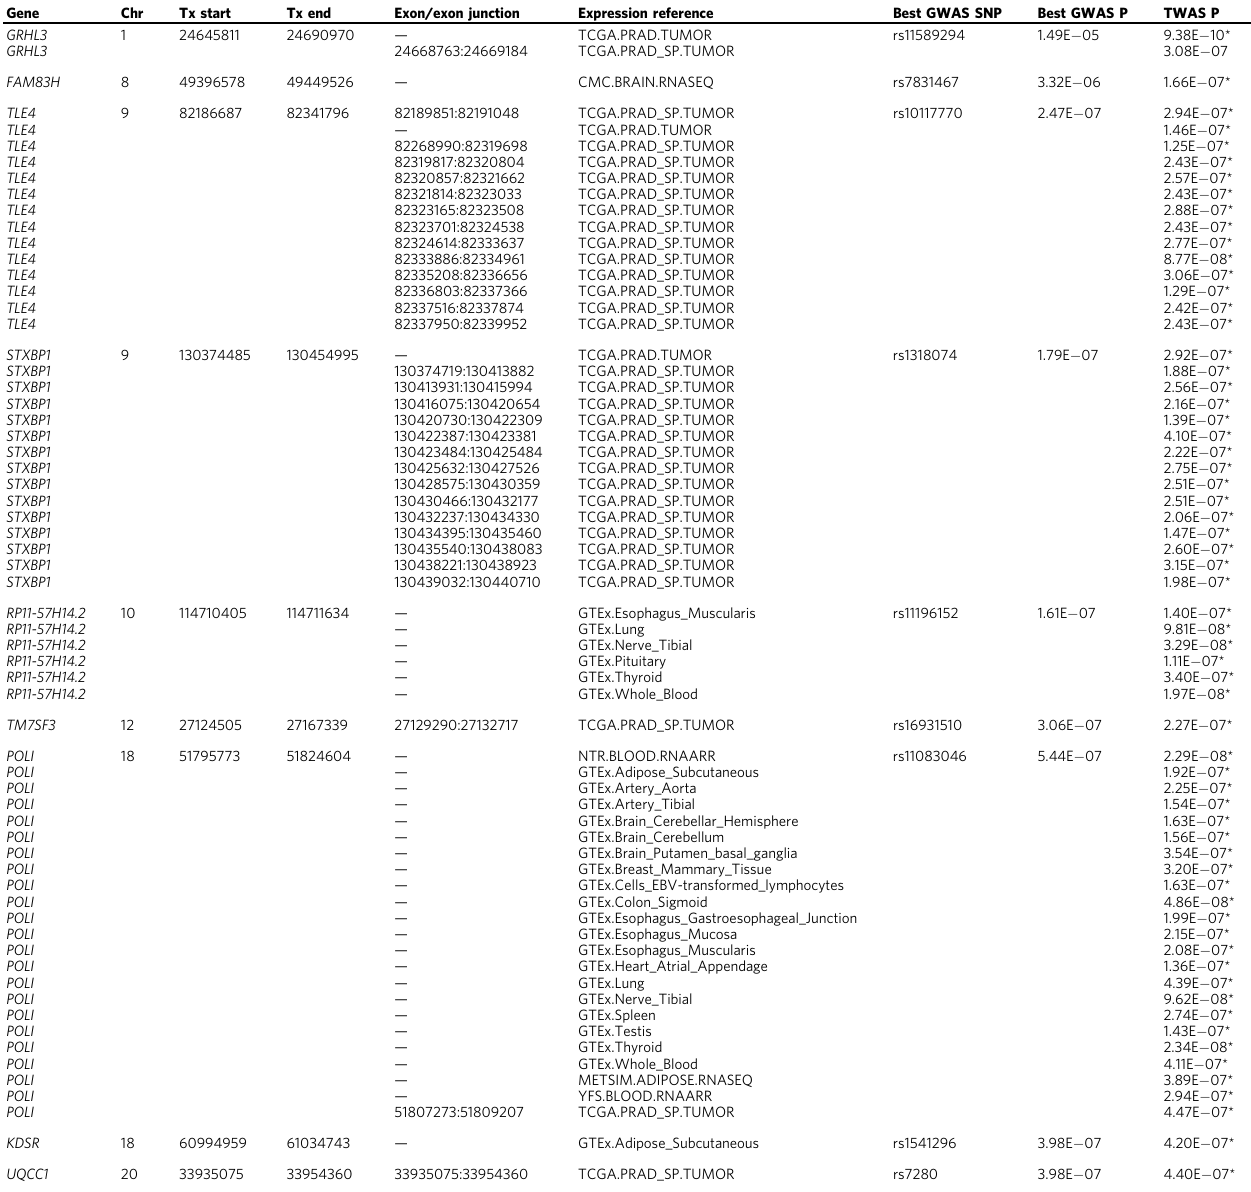
TWAS associations that did not overlap a genome-wide signi fi cant SNP (i.e., ±1Mb transcription start site). Study denotes the original expression panel used to fi t weights. P -value for TWAS computed under the null of no association between gene expression levels and PrCa risk under a Normal (0, 1) distribution. An asterisk (*) indicates associations that are signi fi cant ( P <0.05/9) under